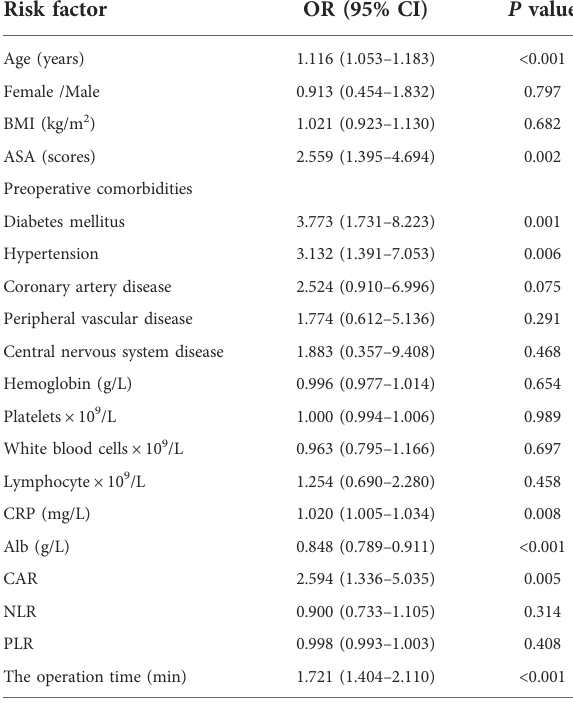
TABLE 4 Logistic regression analysis for POD patients